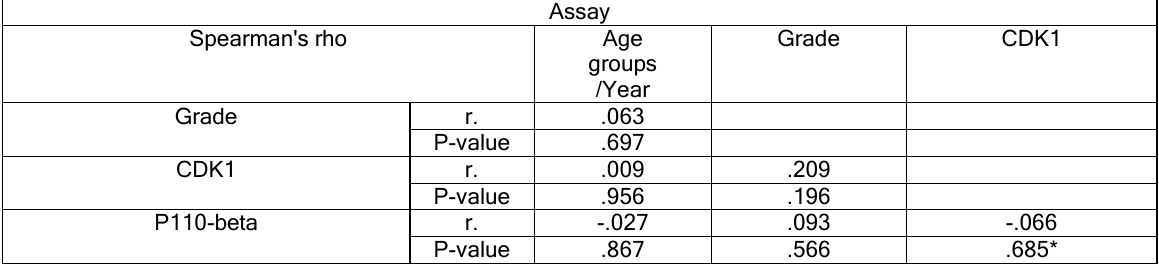
Table (7): Correlations among studied markers P110-beta &CDK1, within Grade and Age in patients with Breast